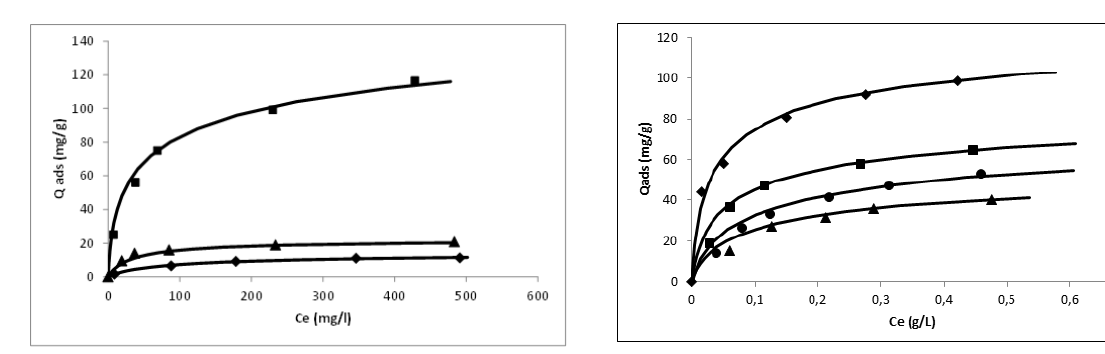
ZnCl 2 , this confirms the results obtained by